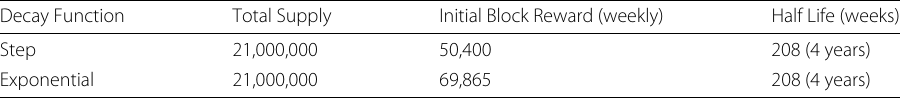
Table 2 Open loop block reward release schedule